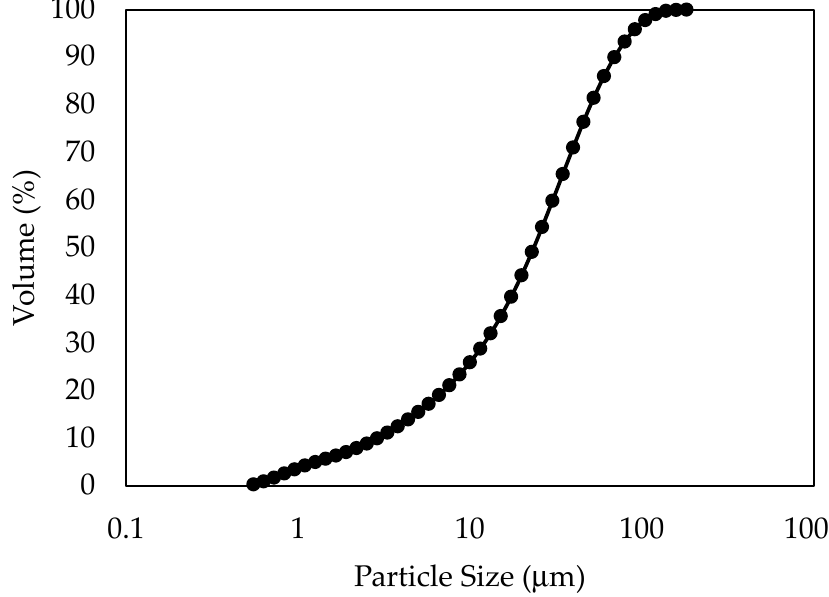
Figure 1. Particle size distribution of wollastonite .